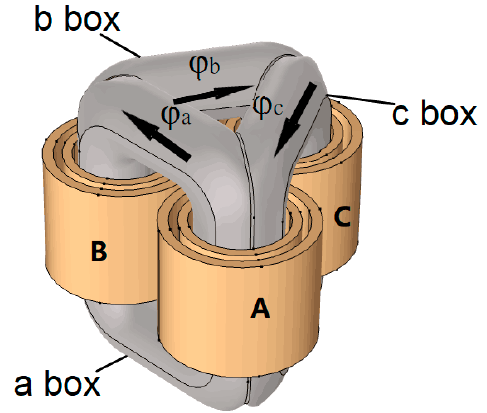
Figure 1. This is a figure. Schemes follow the same formatting. Figure 1. Schemes follow the same